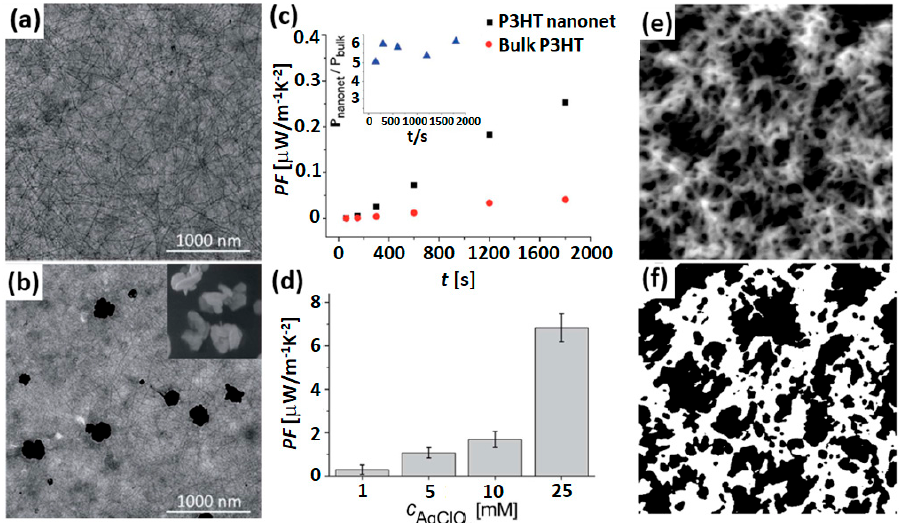
Figure 5. TEM images of ( a ) neutral and ( b ) Ag doped P3HT nanonet (the inset shows a SEM image of the silver particles. ( c ) Comparison of the power factors measured for the bulk and nanonet structured P3HT, doped with 1 mM AgClO 4 solution. ( d ) Maximum power factor of the P3HT nanonet at different oxidant concentrations. ( e ) Scanning force microscopy (SFM) image of a P3HT nanofiber mat (10 × 10 m) and ( f ) corresponding binarized image. Readapted with permission from The Royal Society of Chemistry [62] and MDPI [63].